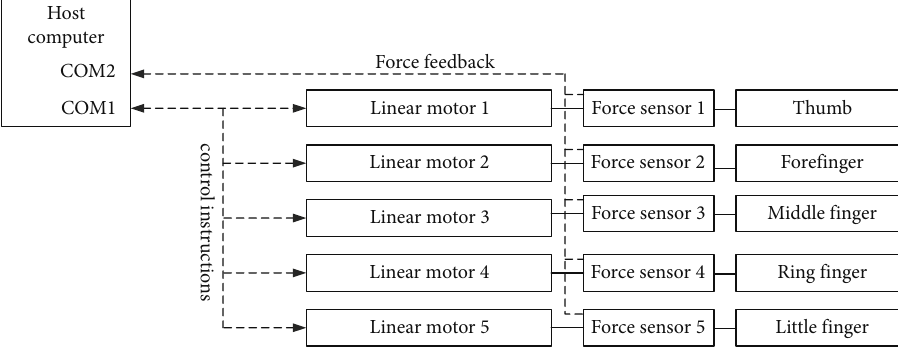
Figure 4: Control system Table 1: Geometrical parameters corresponding to the fore fi nger.